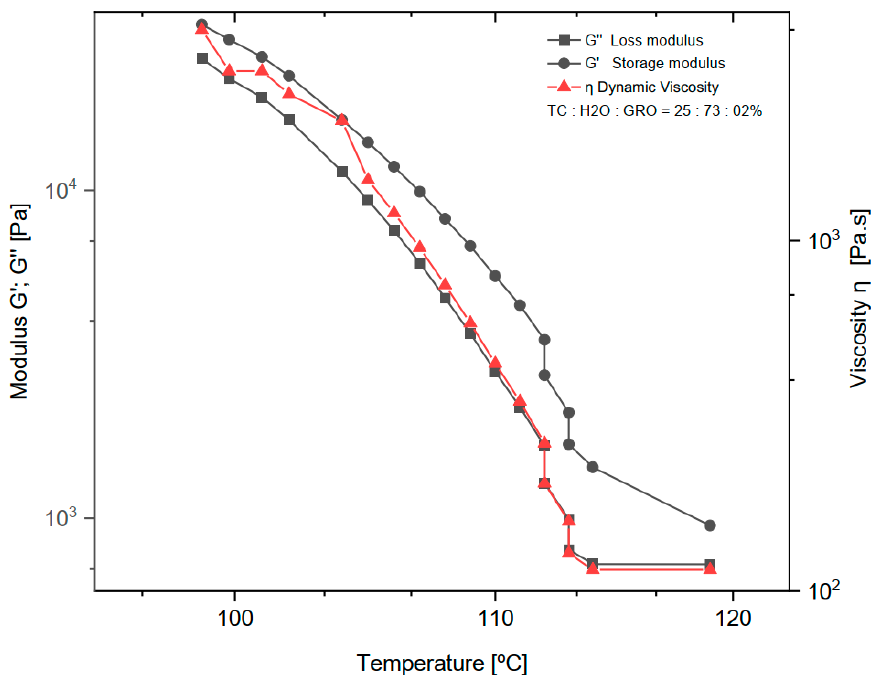
Figure 2. Dynamic viscosity ( η ), loss modulus (G ″ ) and storage modulus (G ′ ) of the mixture of 25:73:2% of TC:water:glycerine. The normal distribution of the model was verified for each group by the Kolmogorov-Smirnov test. The adjusted R-square (R—sq (adj)) for the dynamic viscosity ( η ), loss modulus (G ″ ) and storage modulus (G ′ ) was: 0.894, 0.902, 0.937.